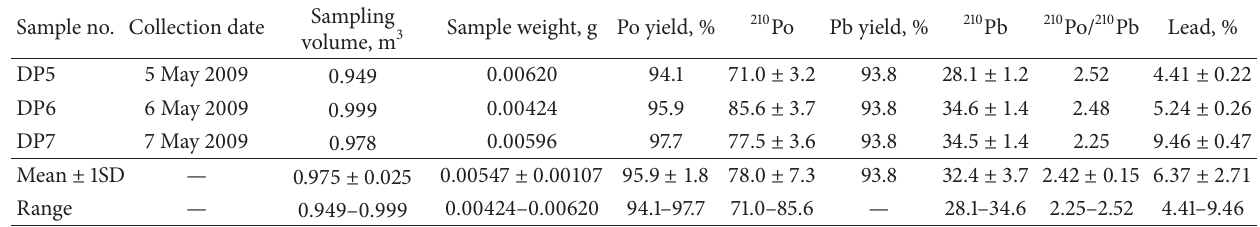
Table 8: The 210 Po and 210 Pb concentrations in kBqkg − 1 and lead contents in the dust particle samples collected at the exit of E312 chimney of the ILVA Taranto on 5–7 May